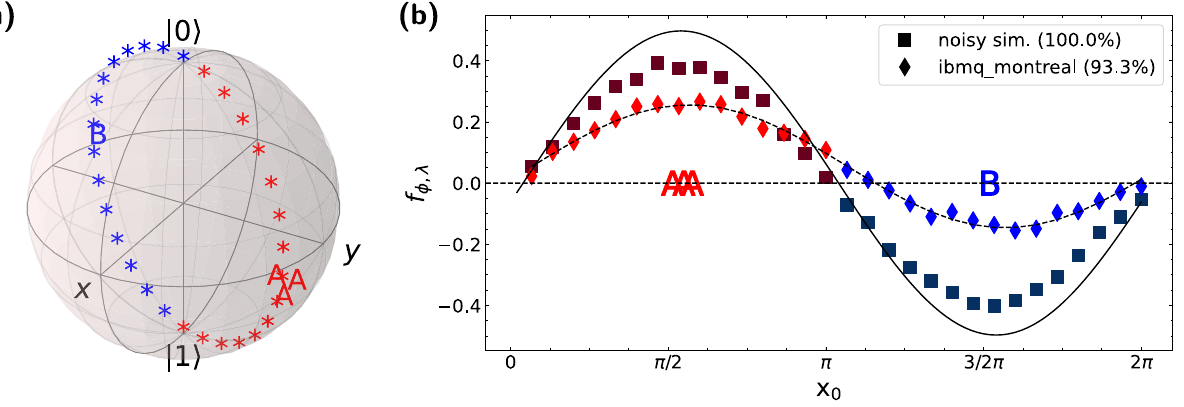
Figure 3. Experiments on a ibmq_montreal cloud NISQ processor. ( a ) The toy training (letters) and test (asterisk) data are shown here in a Bloch sphere. The color indicates the true class label of the data; i.e., red = class A, and blue = class B. The letters A represent the training data of class A, and letter B represents the training datum of class B. ( b ) classification results performed on ibmq_montreal QPU (diamonds) and a simulation with noise (squares) compared to theoretical values(solid line). f φ , (cid:31) is the decision function value of each test datum. The letters A and B represent the training data, located at their longitudinal coordinates on the Bloch sphere ( x 0 ). Curved dashed lines are the sine-fitting of the ibmq_montreal results. Values inside the round brackets in the legend are the classification accuracy